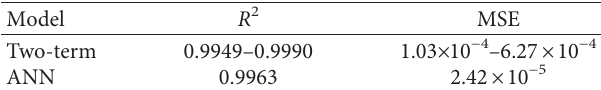
Table 6: Comparative analysis of semiempirical and ANN model.